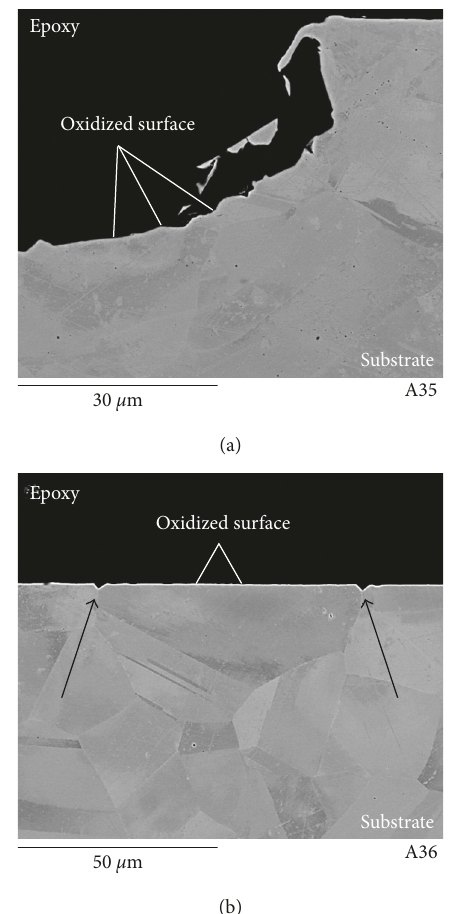
Figure 4: SEM micrographs of alloys A35 (a) and A36 (b) after potentiodynamic polarization experiments (cross sections).